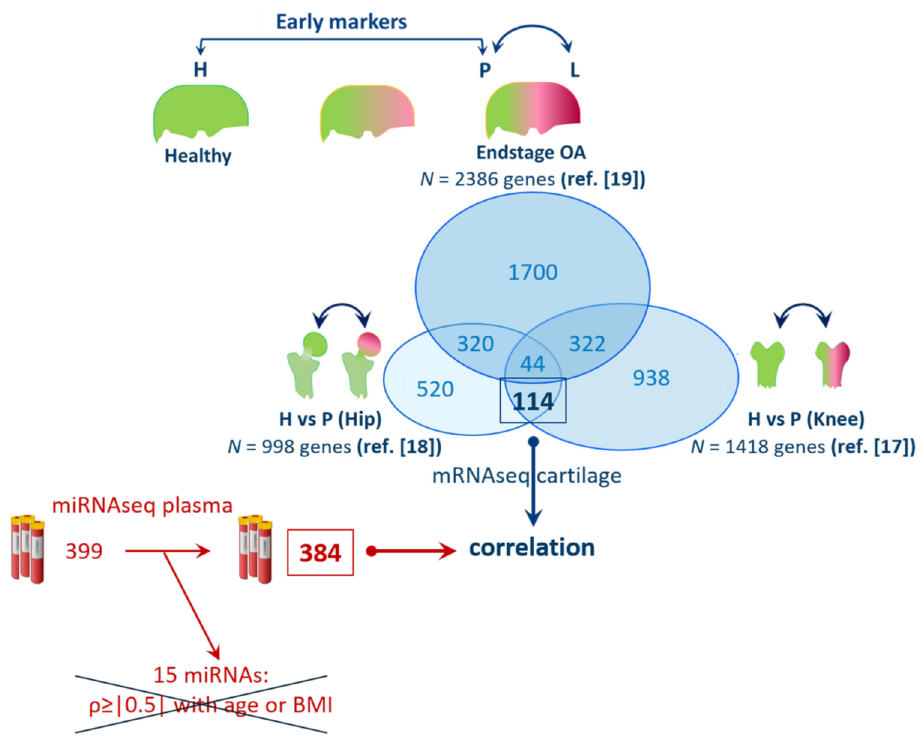
Figure 1. Selection of 114 genes marking early changes in articular cartilage and correlating to levels of 384 plasma miRNAs (Legend—H: healthy cartilage; P: preserved; and L: lesioned OA cartilage; ref.: references used in this paper for the selection of genes; 15 miRNAs were disregarded due to their potential correlation ρ ≥ |0.5| with age and